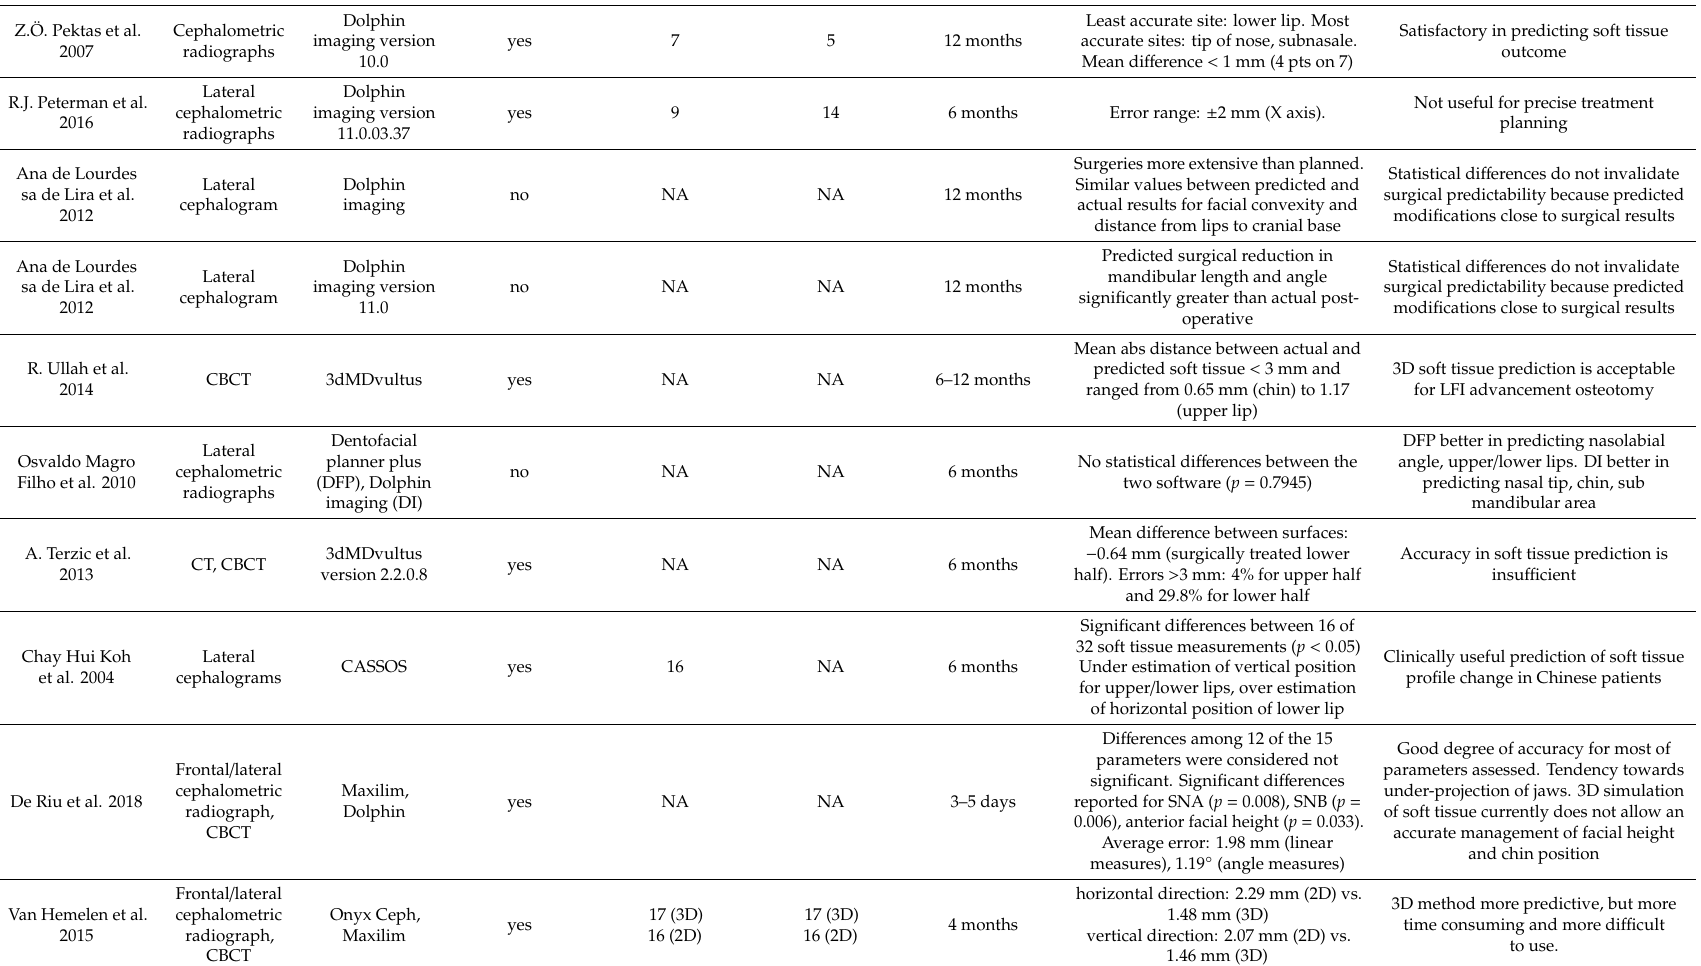
Least accurate site: lower lip. Most accurate sites: tip of nose,